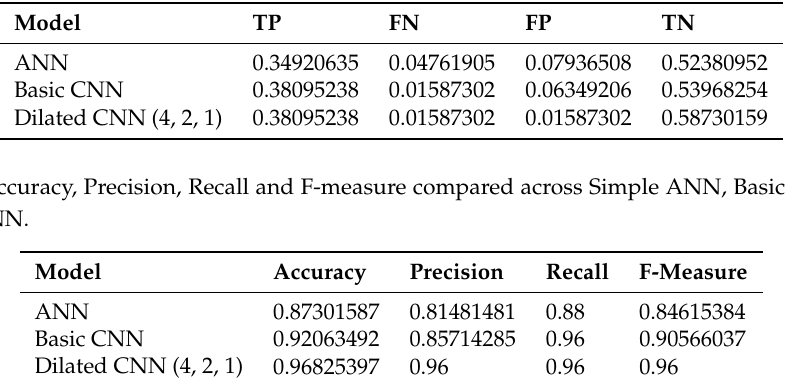
Table 1. True Positive, False Negative, False Positive and True Negative rates compared across Simple ANN, Basic CNN and Dilated CNN.